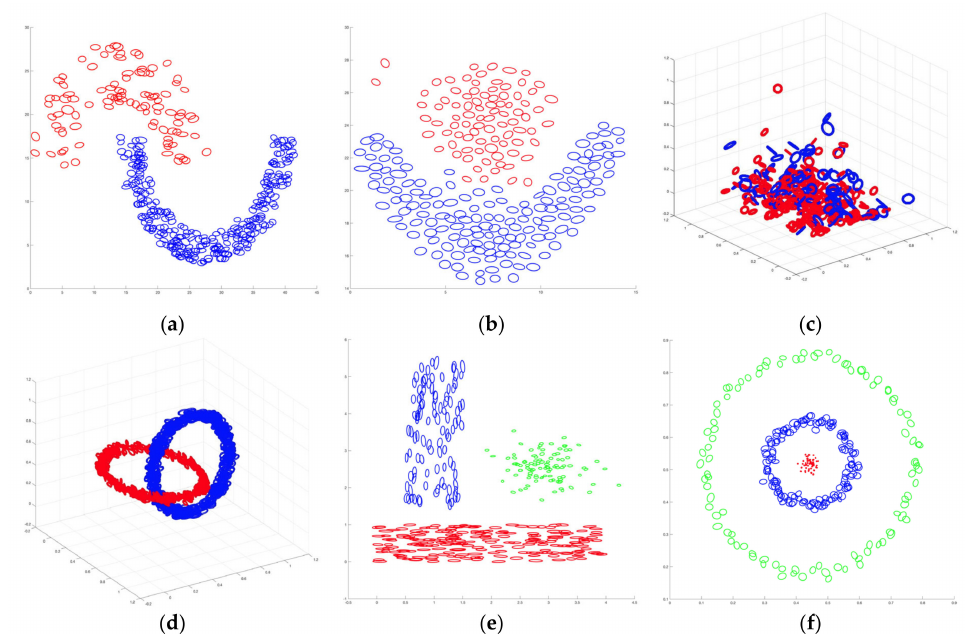
Figure 3. Shapes of 2D and 3D datasets: ( a ) D1 dataset; ( b ) D2 dataset; ( c ) D7 dataset; ( d ) D8 dataset;